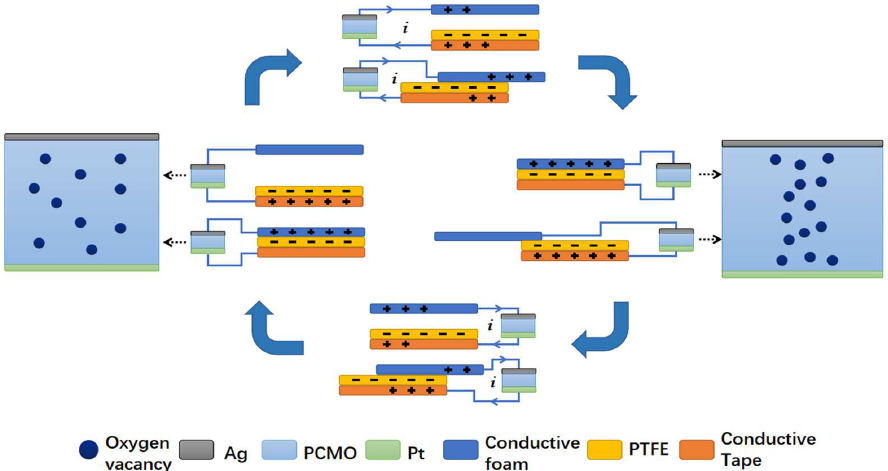
Figure 5. Schematic illustration of the underlying mechanism of the self-powered RRAM.